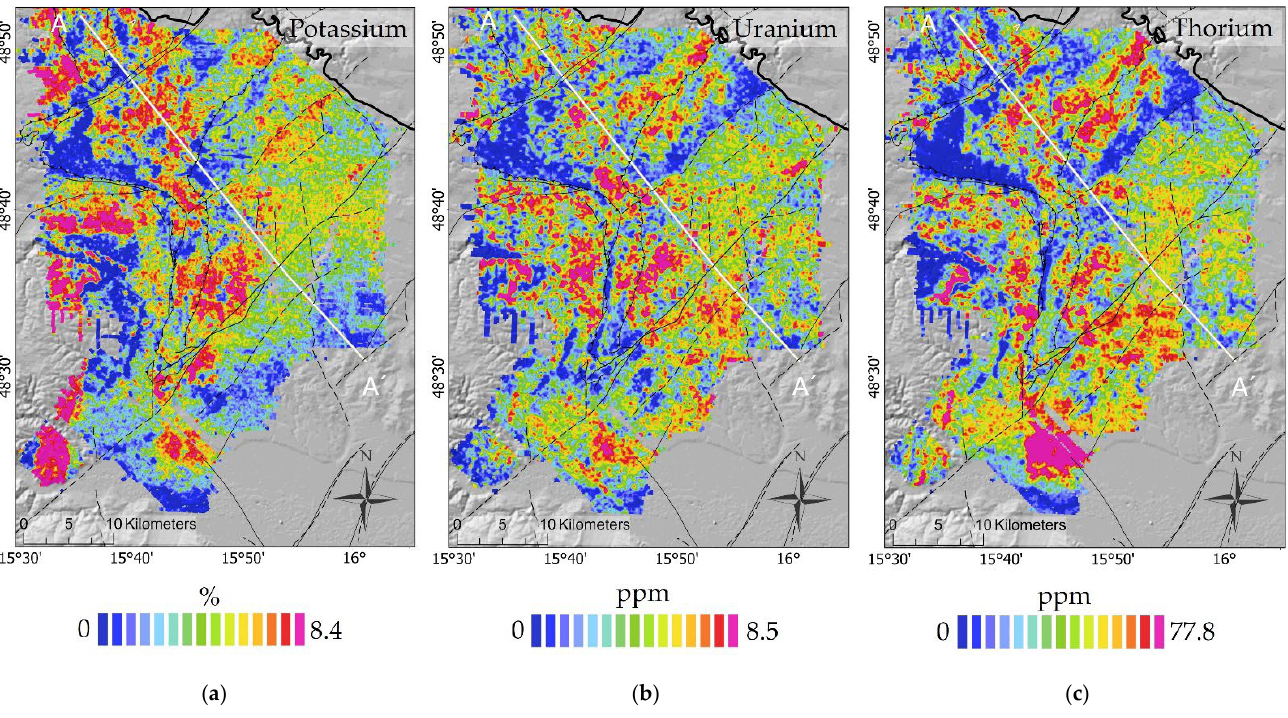
Figure 4. ( a ) Potassium map ( b ) Uranium map ( c ) Thorium map. Location of profile A (white line) is shown for orientation. Black lines indicate geological faults; see legend in Figure 1b for details. Background map: Lidar image with a 10 × 10 m resolution.